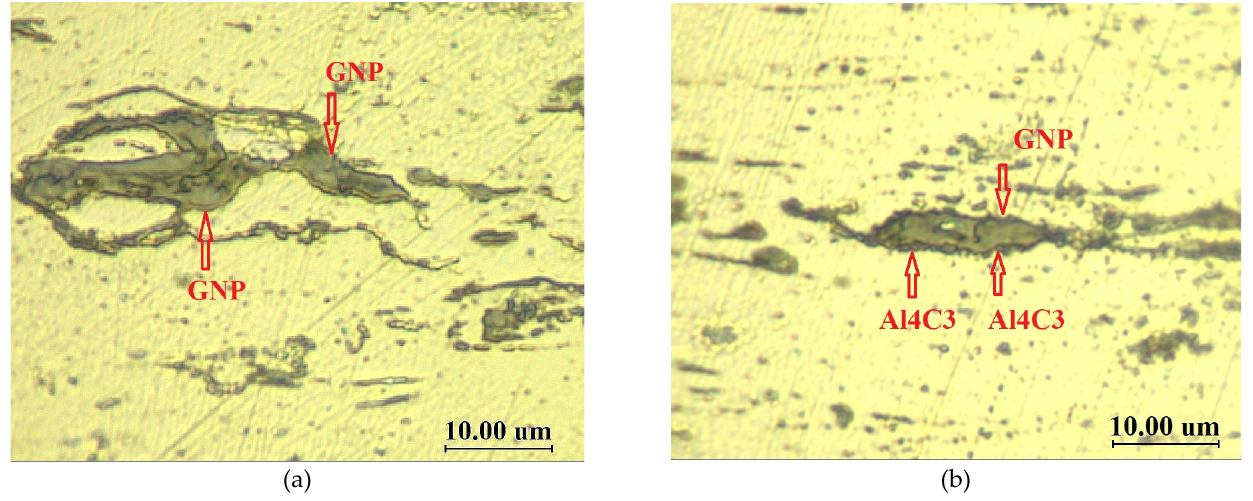
Figure 1. Sample reinforced by 1.1 wt.% GNPs: ( a ) before heat treatment; ( b ) after heat treatment.